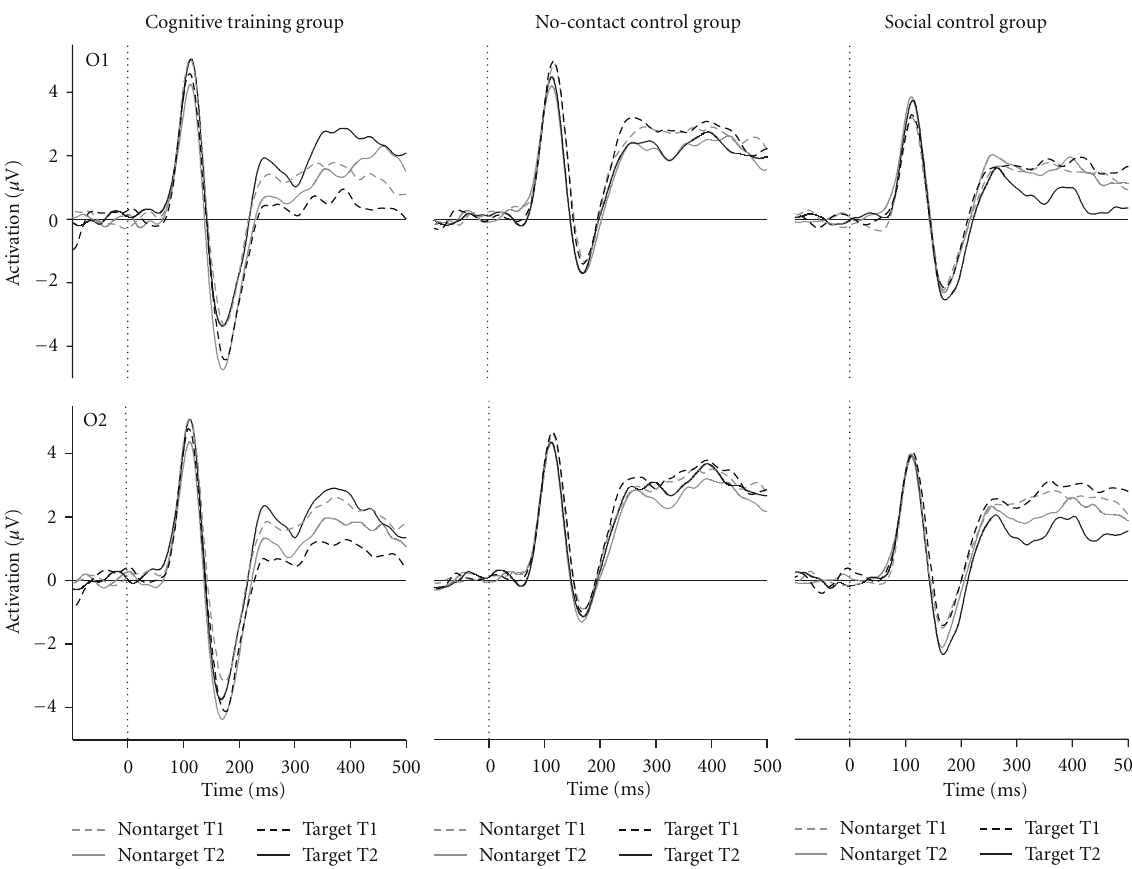
Figure 1: Stimulus-locked event-related potentials at the occipital electrodes O1 and O2 separately for target and non-target trials, for the first (T1) and the second test session (T2) as well as for the cognitive training group, the no-contact control group and the social control group. Note that the N1 is the pronounced negative peak in the interval between 150 to 200